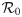
Sensitivity analyses for R0: (a) The impact of p when γ = 0.22, η = 0.142, f = 0, α = 0, (b) the impact of η when γ = 0.22, p = 0.33, f = 0, α = 0; sensitivity analyses for Rc: (c) the impact of f when γ = 0.22, η = 0.142, p = 0.33, α = 0, (d) the impact of α when γ = 0.22, η = 0.142, f = 0, p = 0.33.